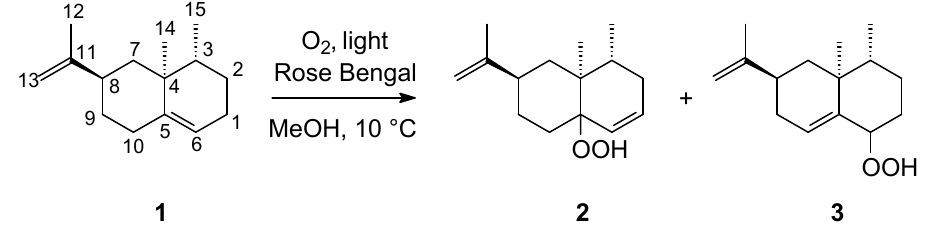
Figure 2. Photooxidation of (+) ‐ valencene in methanol.